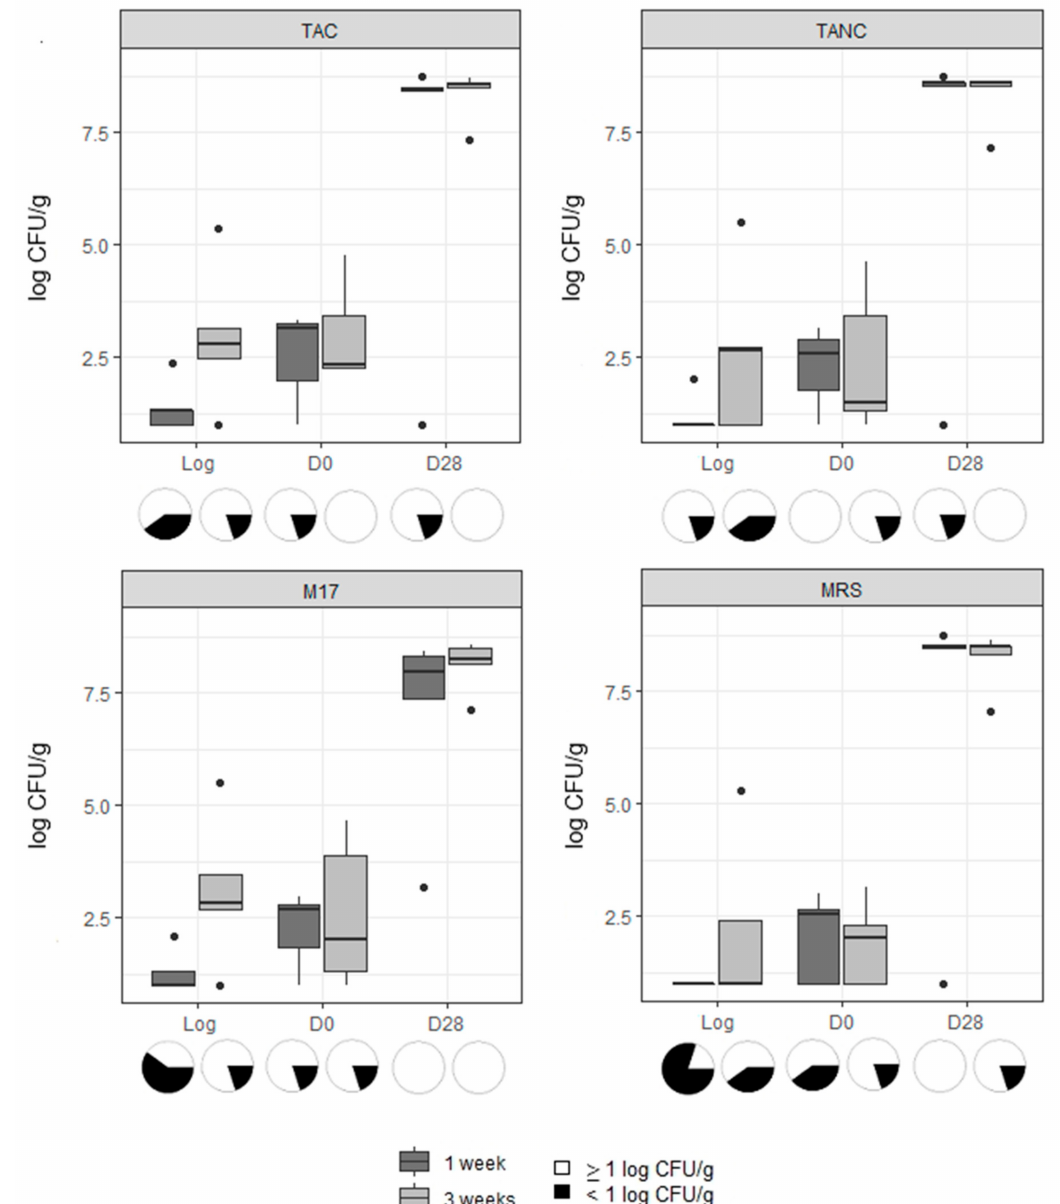
Figure 2. Log(CFU/g) values for total psychrotolerant and psychrophilic aerobic (TAC), and anaerobic counts (TANC) and lactic acid bacteria counts (M17 and MRS agar) found on cooked ham samples. The boxplots represent the 1st quartile, median, 3rd quartile and, if applicable, outliers of each dataset. Each boxplot contains five data points, except for when a sample was below the enumeration limit of 1 log CFU/g. In these cases, n will deviate. Deviation in data points is visualized by pie charts: white representing the countable samples and black representing the samples below the enumeration